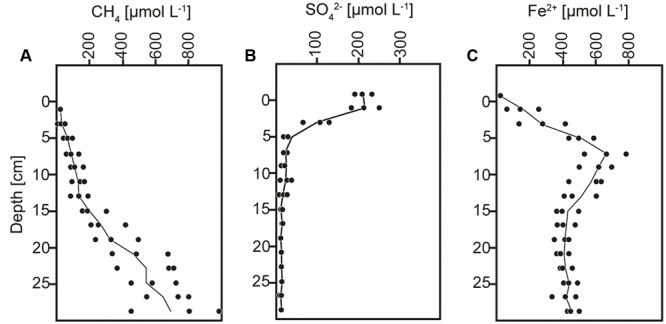
Concentration depth profiles of (A) methane (CH4), (B) sulfate (SO42-), and (C) dissolved iron (Fe2+).